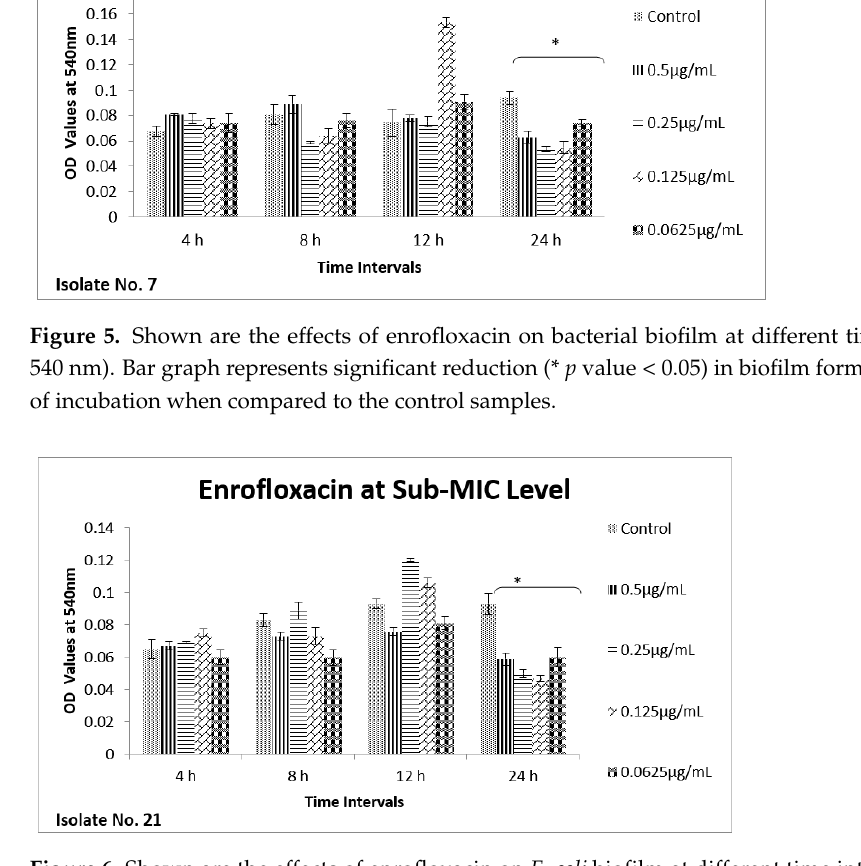
Figure 6. Shown are the effects of enrofloxacin on E. coli biofilm at different time intervals (OD 540 nm). Bar graph represents significant reduction (* p value < 0.05) in biofilm formation up to 24 h, of incubation when compared to the control samples.